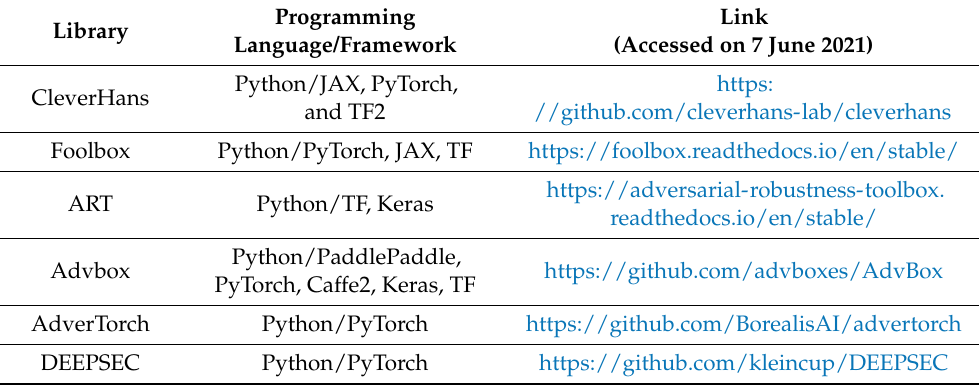
Table 4. Main characteristics of the available open-source libraries.